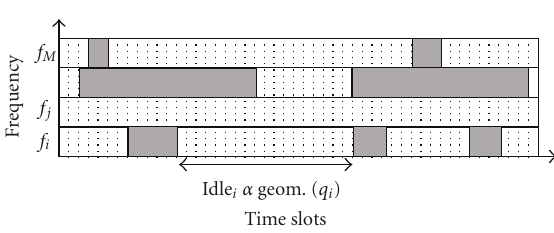
Figure 2: The duration of idle and busy periods normalized to slot time form discrete random